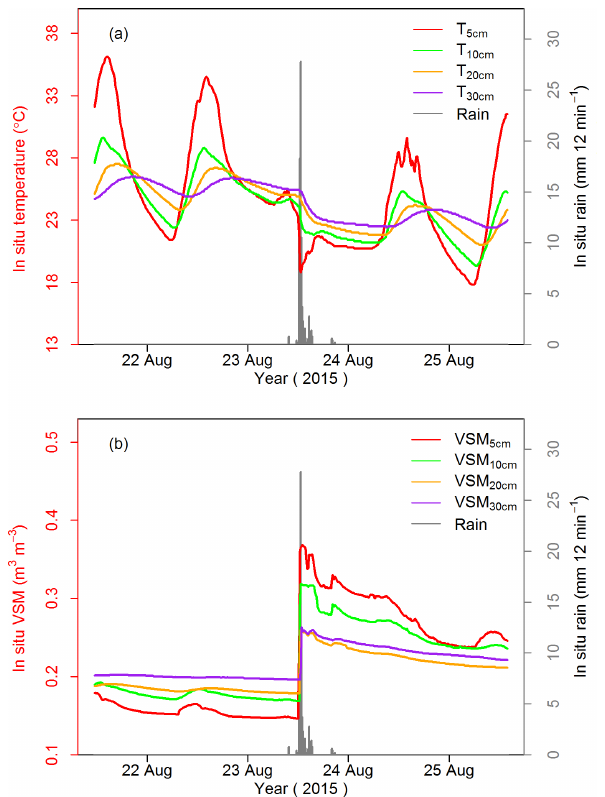
Figure 2. In situ soil temperature (a) and soil moisture (b) mea- sured at the PRD station from 21 to 25 August 2015 at depths of 5, 10, 20, and 30cm, together with the in situ rainfall observations (mm12min − 1 ) shown in